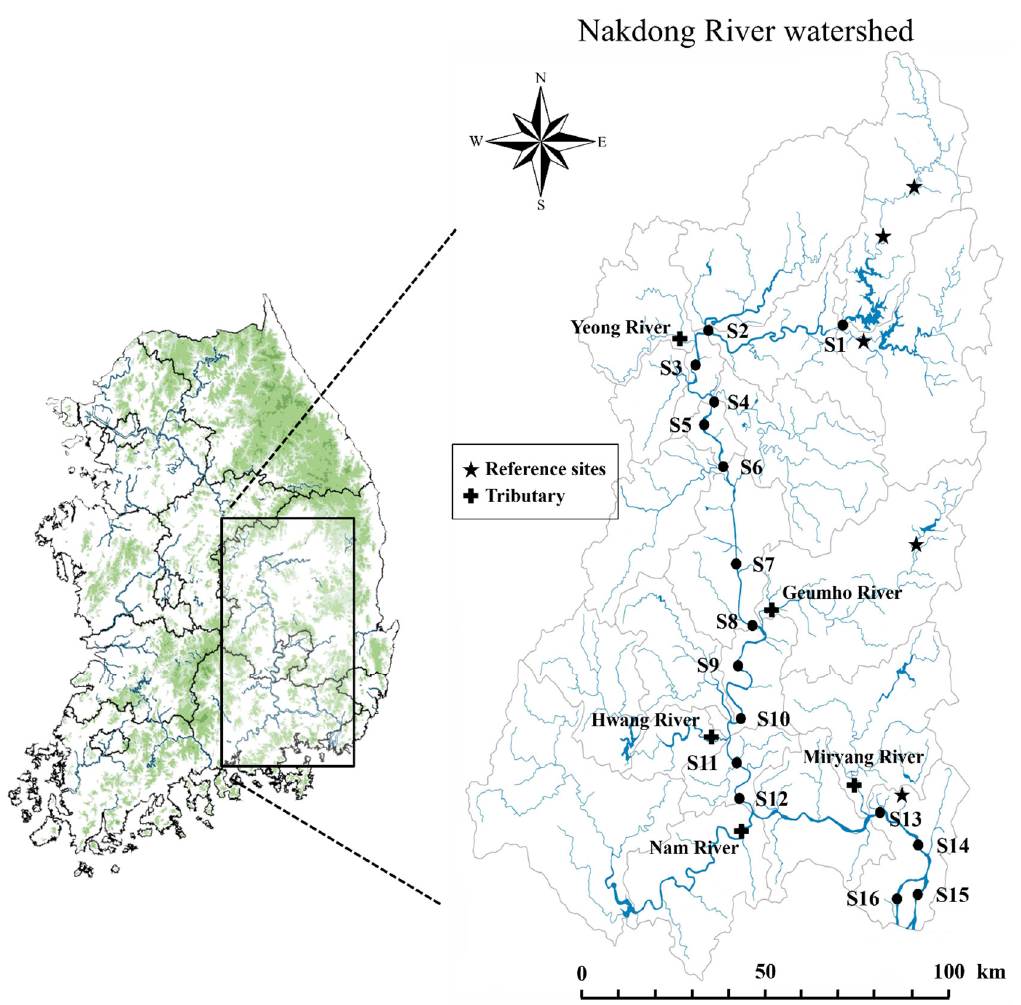
Figure 1. Map showing sampling sites in Nakdong River